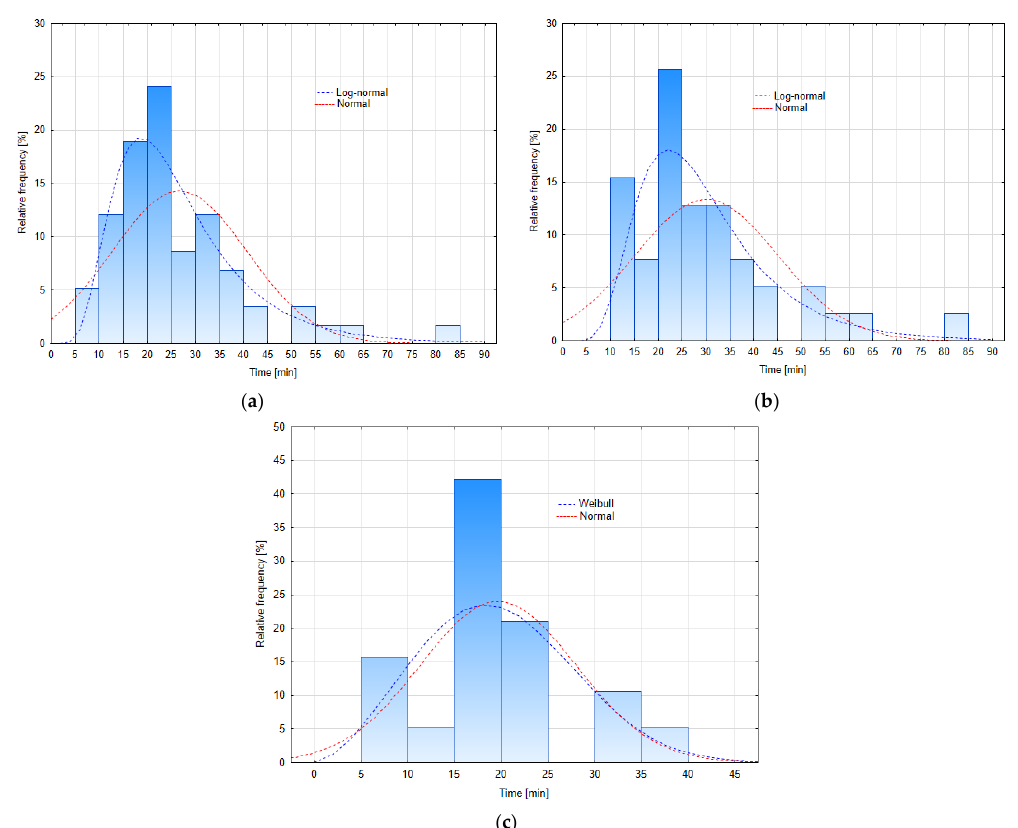
Figure 2. Histograms of the TCPA at the start of the anti-collision manoeuvre and the best fitted theoretical distributions for all situations ( a ) in the open sea area ( b ) and in the restricted sea area ( c ).